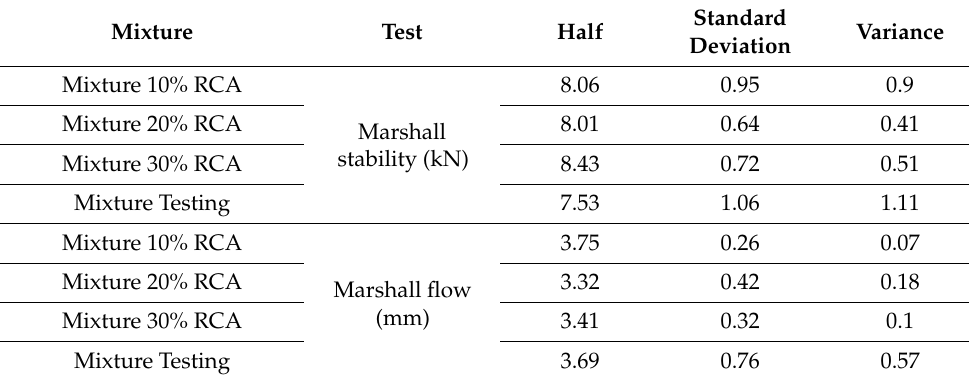
Table 3. Descriptive statistics of the different